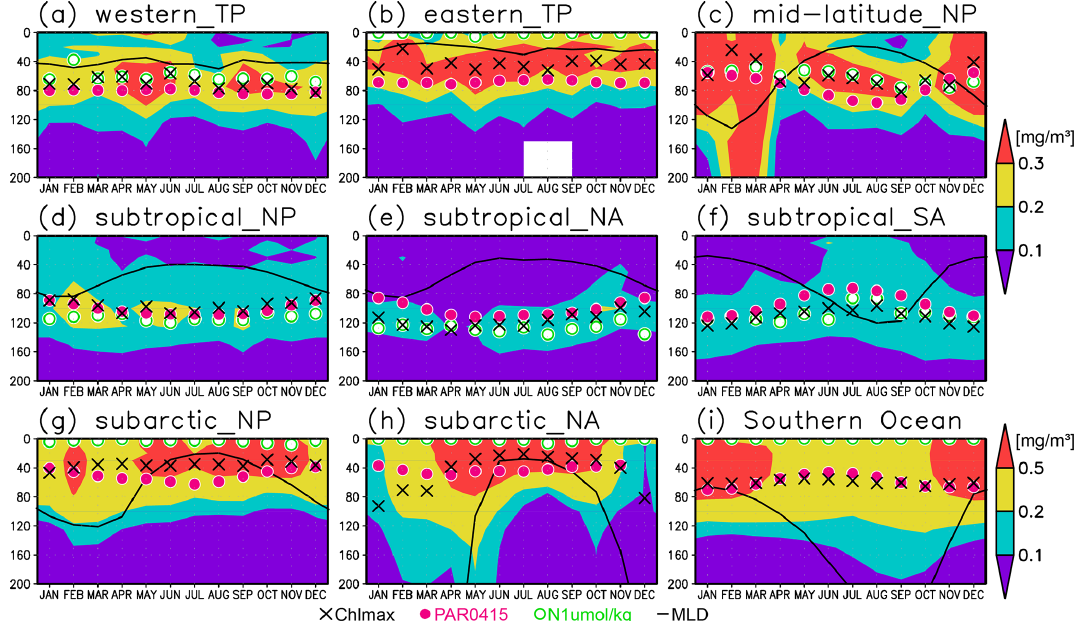
Figure 10. Seasonal evolution of chlorophyll a (Chl a ) concentrations with the Chl a maximum (black crosses), 0.415molm − 2 d − 1 of photosynthetically available radiation (magenta dots), 1µmolkg − 1 of nitrate (open green circles), and the mixed layer (solid black line)